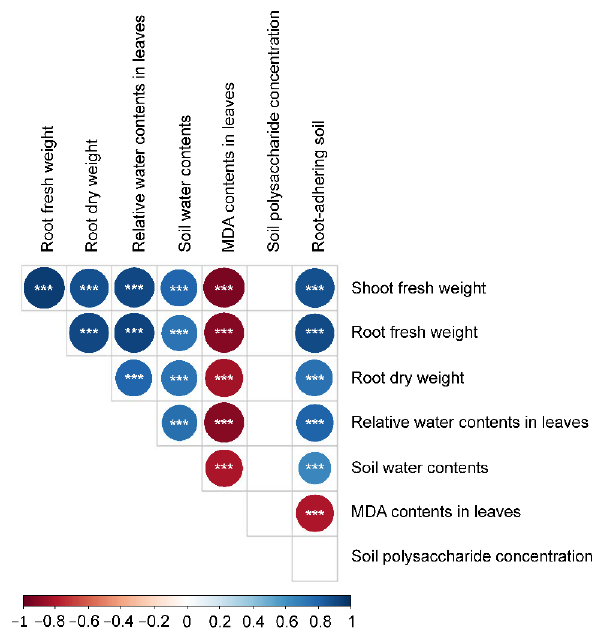
Figure 6. Correlogram of Spearman’s correlation coefficients between RDPIs of plant traits and soil characteristics. Negative correlations are in red and positive correlations are in blue. *** p < 0.001.